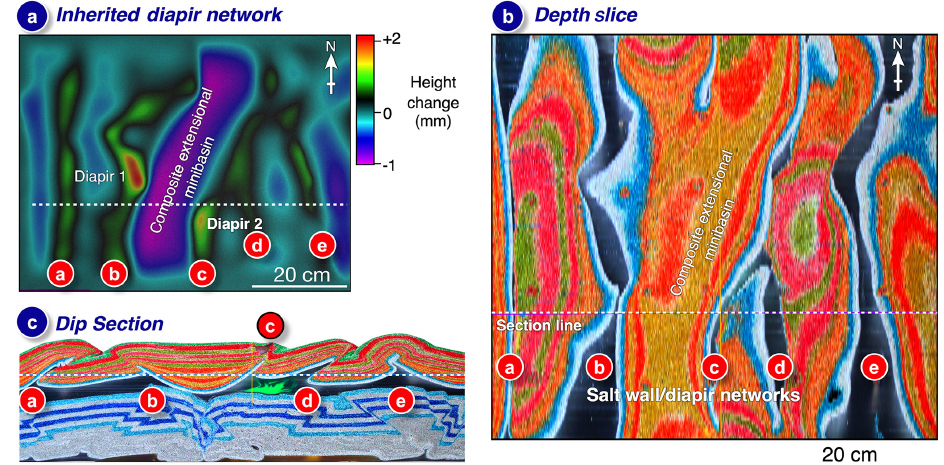
Figure 13. (a) Height-change map from Stage 3 of Model 1 illustrating the diapir and ridge networks that formed during extension rising during post-extension loading. ( b and c ) Depth slice and dip section through Model 1 illustrating the five (a–e) main diapir networks.